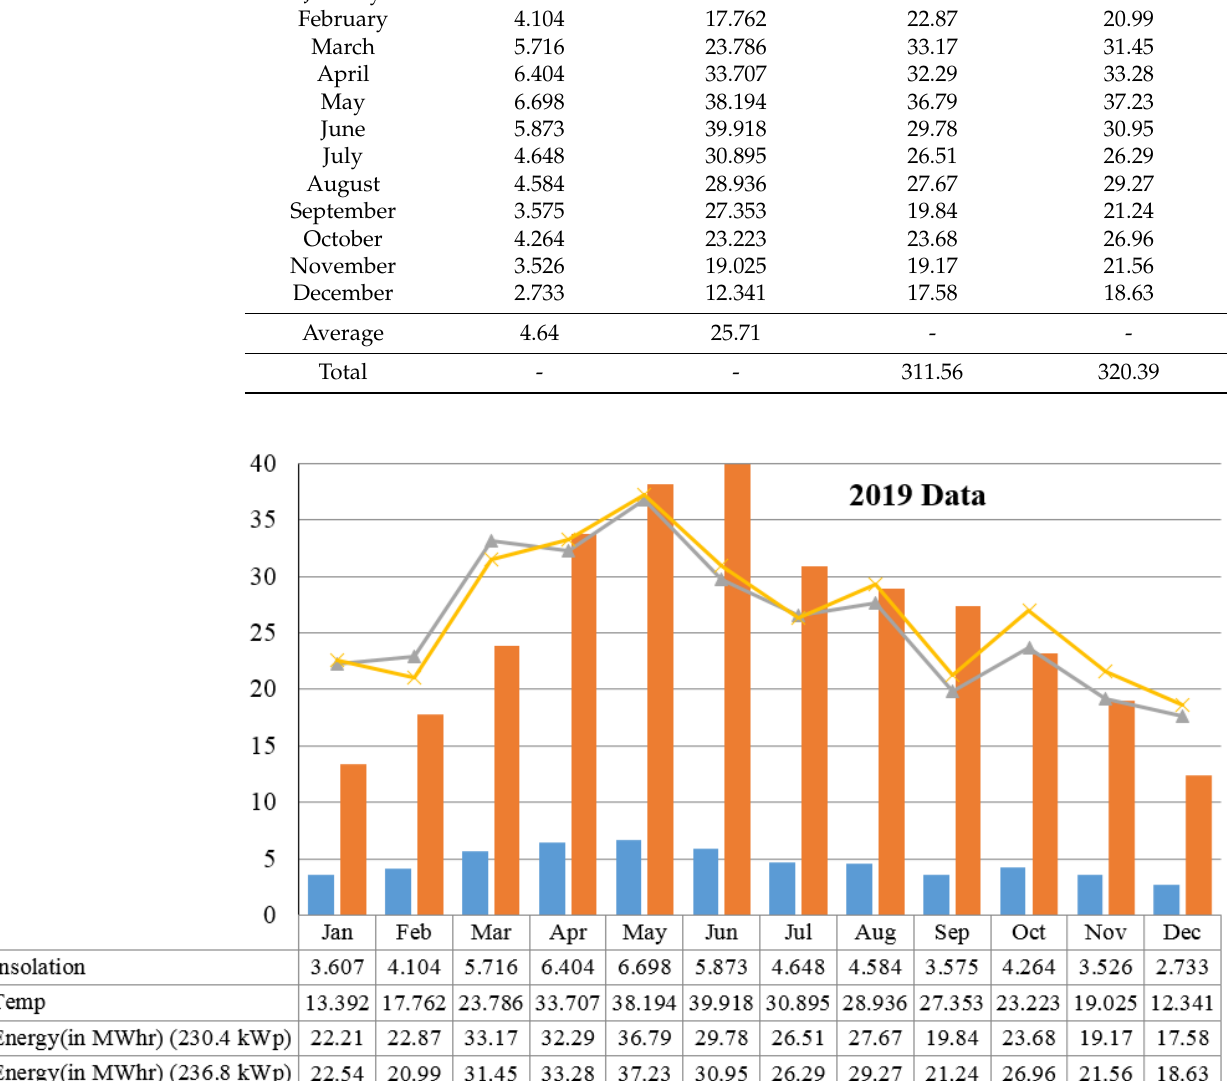
Figure 6 . Comparison of Generated Energy in 2019 (P 1 vs. P 2 + P 3 ) . Figure 6. Comparison of Generated Energy in 2019 (P